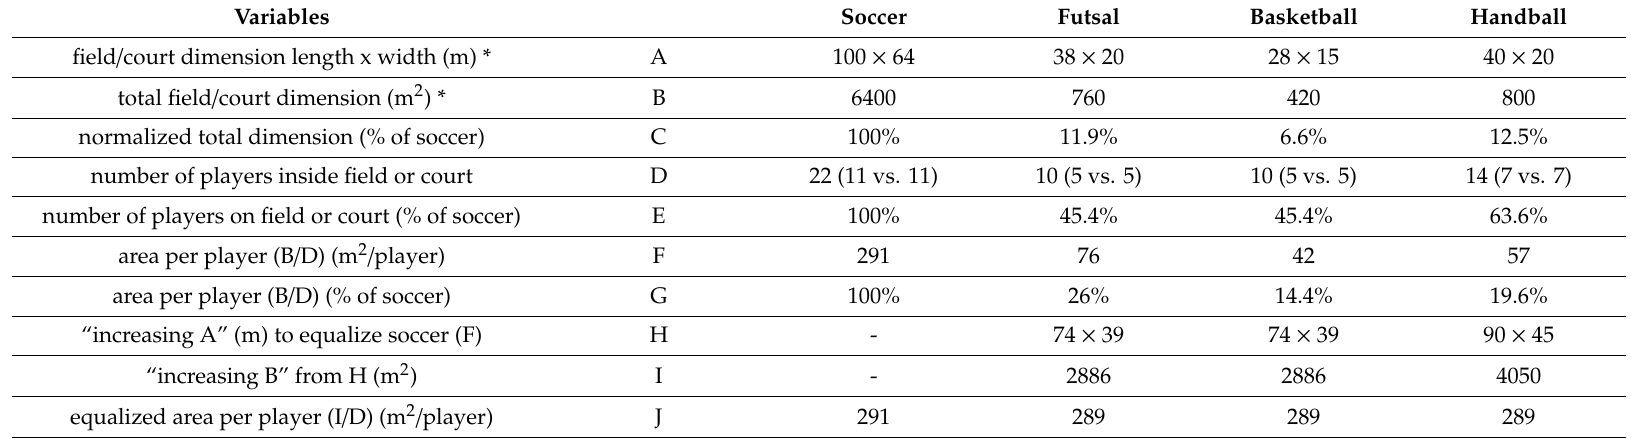
Table 2. Simulations to equate to soccer dimensions (6400 m 2 / 22 players = ~291 m 2 / players), changing the current court dimensions. Variables Soccer Futsal Basketball Handball field / court dimension length x width (m) * A 100 × 64 38 × 20 28 × 15 total field / court dimension (m 2 ) * B 6400 760 420 800 normalized total dimension (% of soccer)